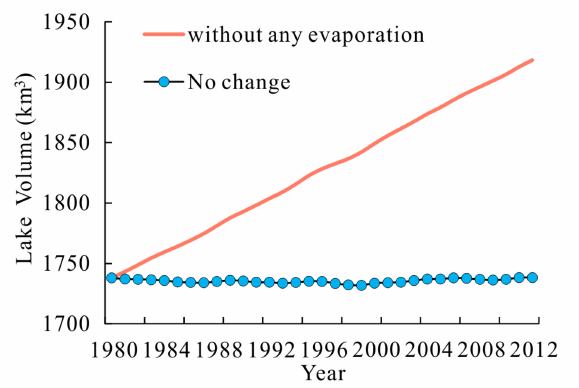
Figure 5. Change of Issyk-Kul lake volume with and without evaporation.